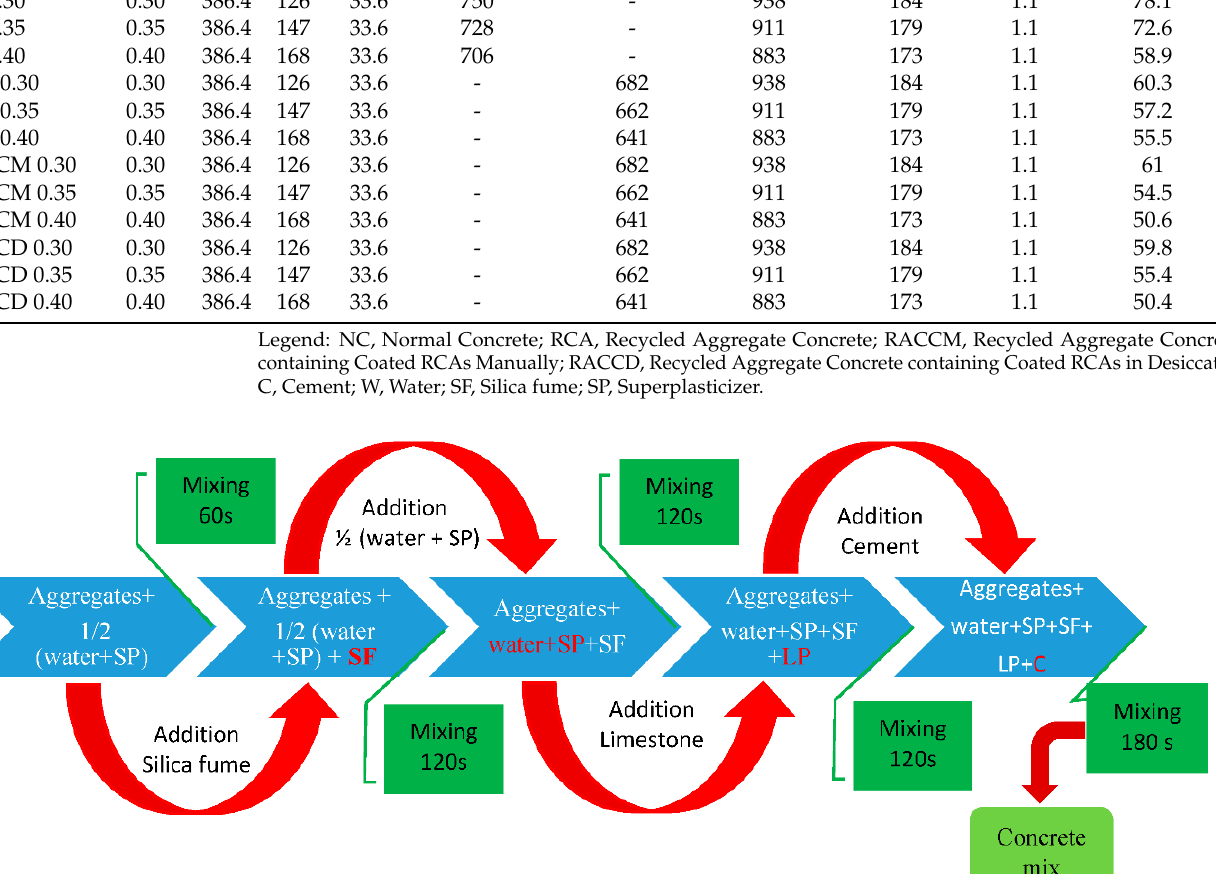
Table 4. Mix proportion, slump, and compressive strength.